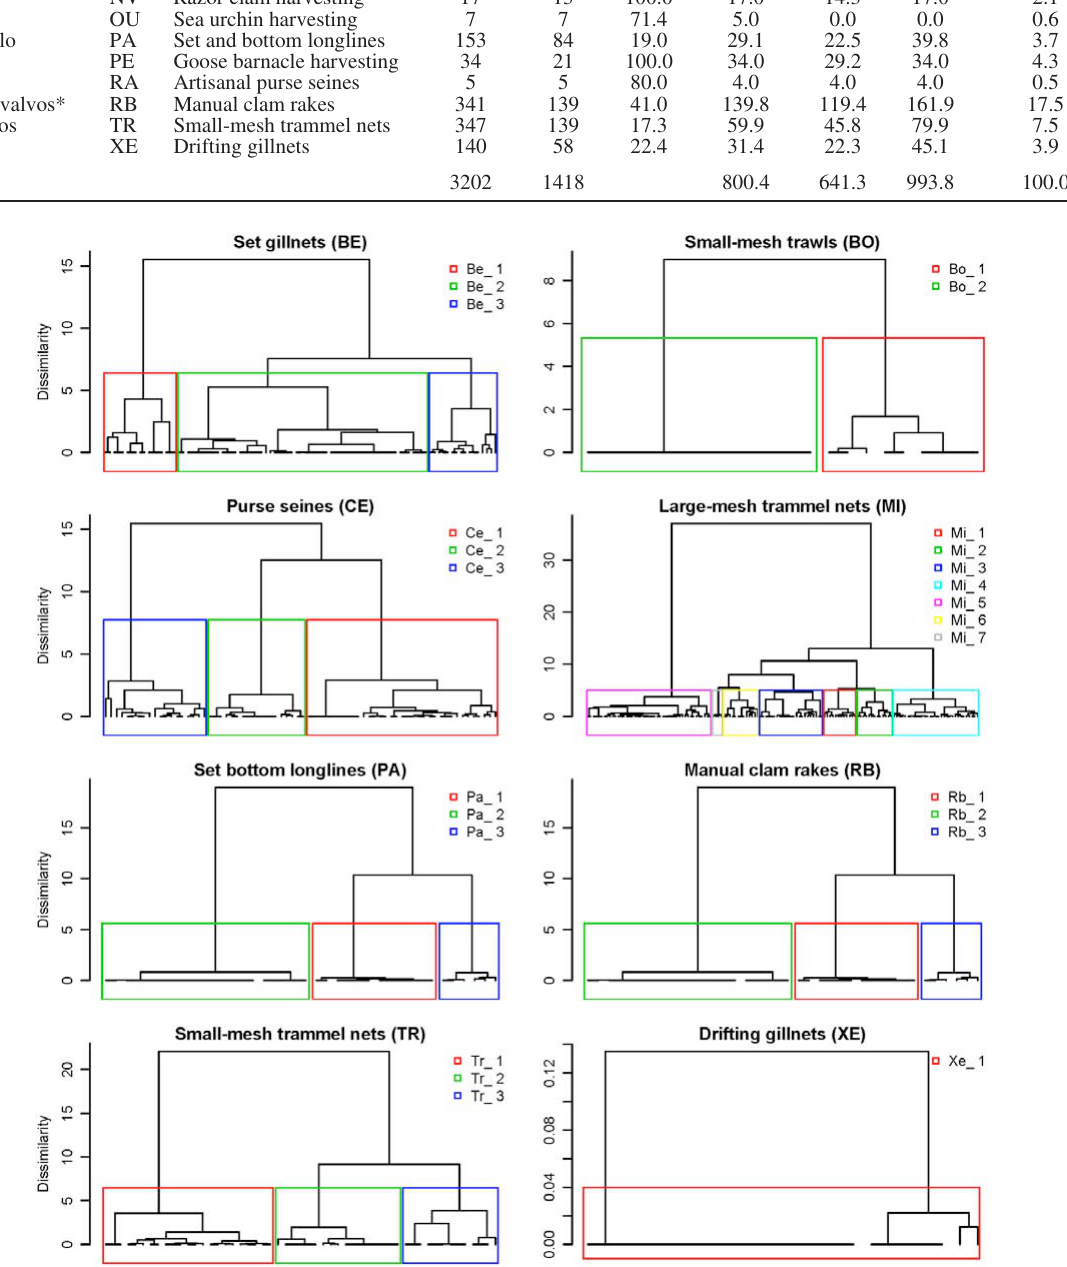
Fig. 2. – Dendrograms from hierarchical clustering using species catches data. Groups identified as distinct fishing strategies within fishing gear are shown. Note that the scale in the Y-axis changes between